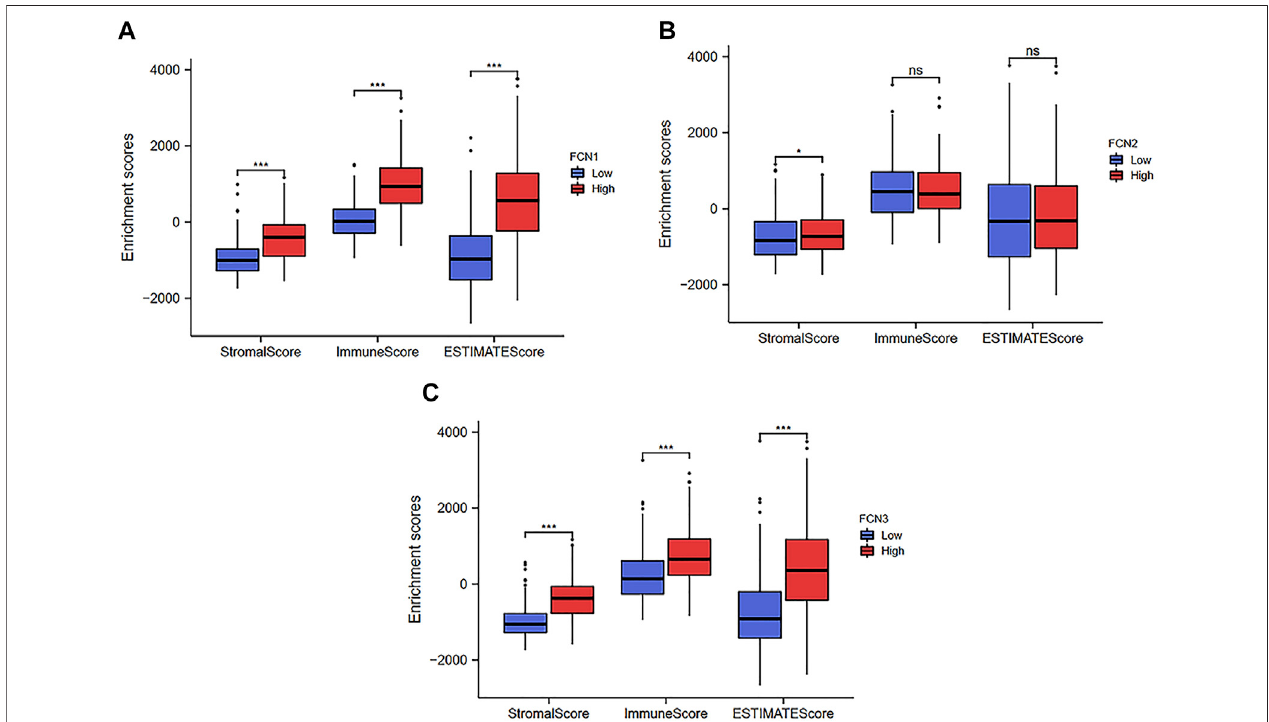
FIGURE 9 | Stromal and immune cell scores in LIHC. (A) FCN1; (B) FCN2; (C) FCN3; * p < 0.05, ** p < 0.01, *** p <